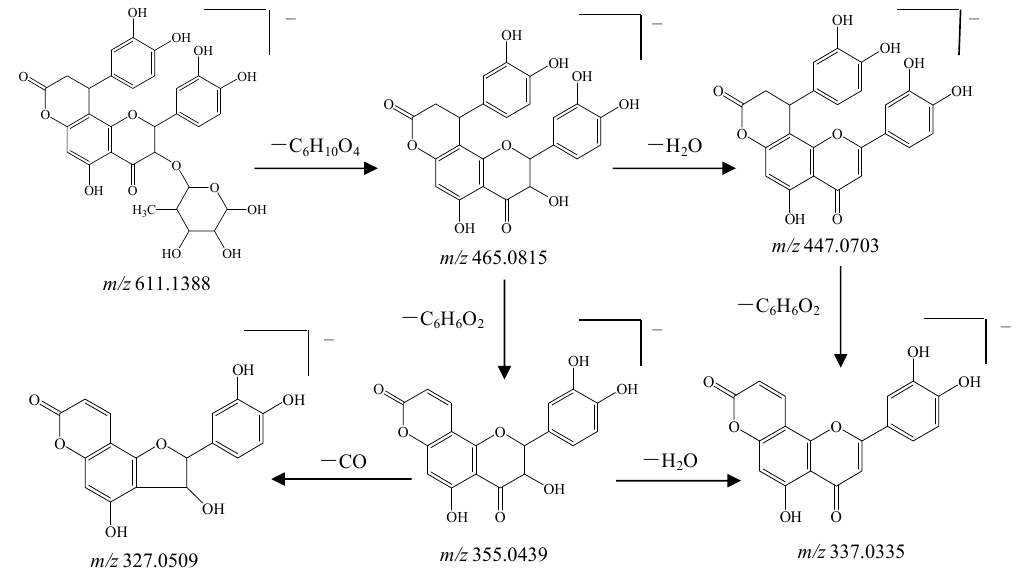
Figure 6. ( A ) Extracted ion chromatogram (EIC) of compounds 21 – 26 ; ( B ) MS/MS spectrum of compound 24 ; ( C ) proposed fragmentation pathway of compound 24